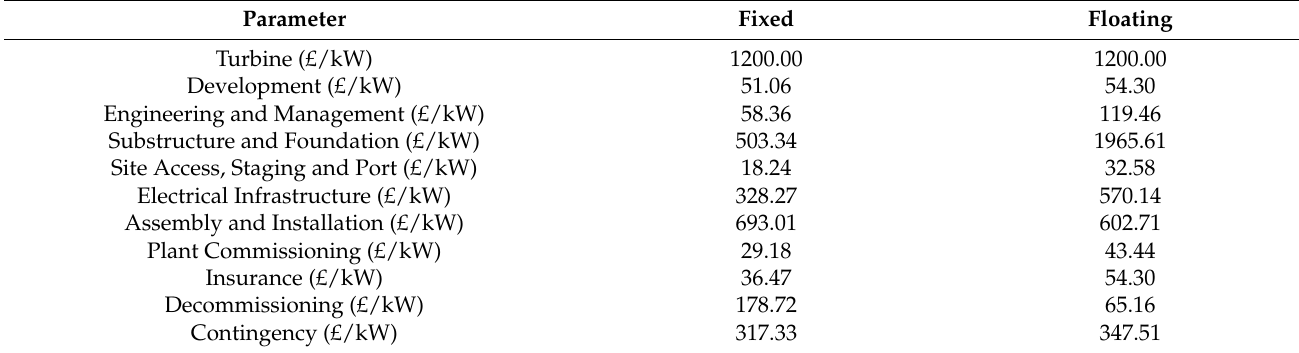
Table 7. Fixed and Floating Parameter Valuations